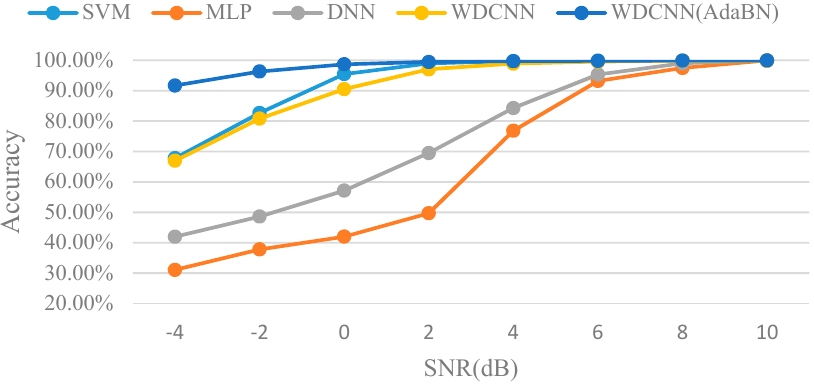
Figure 12. Comparison of classification accuracy under different noisy environment.